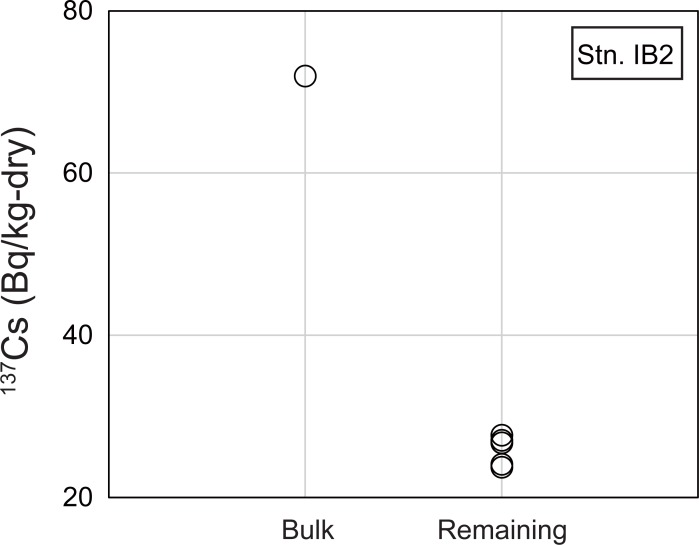
Comparison of 137Cs concentrations between the bulk sample and remaining sample from Stn. IB2.